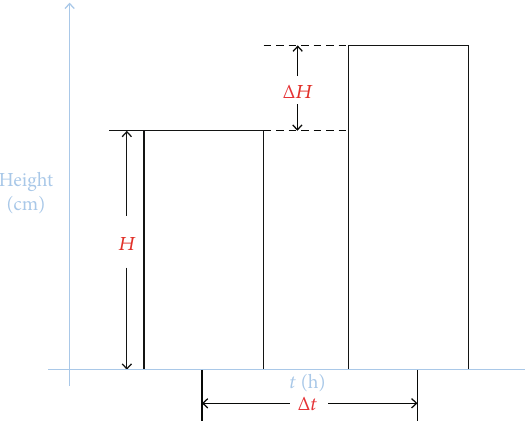
Figure 9: Schematic diagram of calculated parameters of soil column.